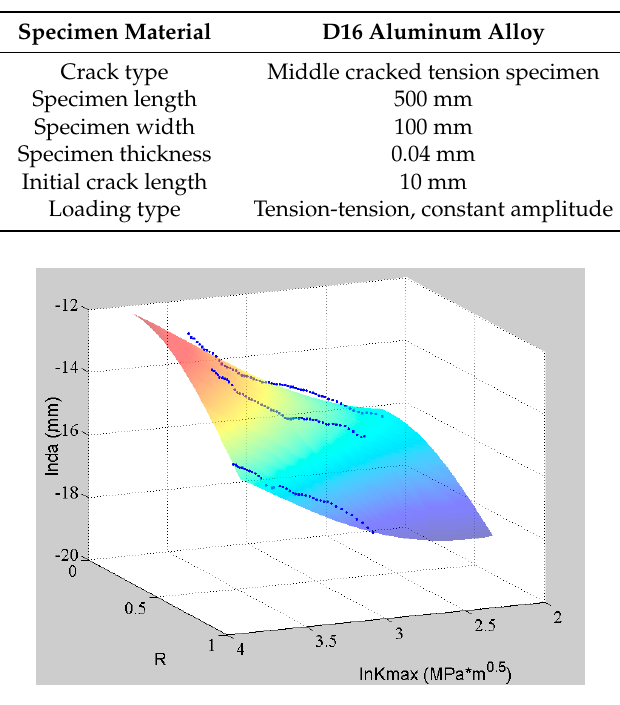
Figure 14. The experimental data of D16 aluminum and the corresponding ANN.